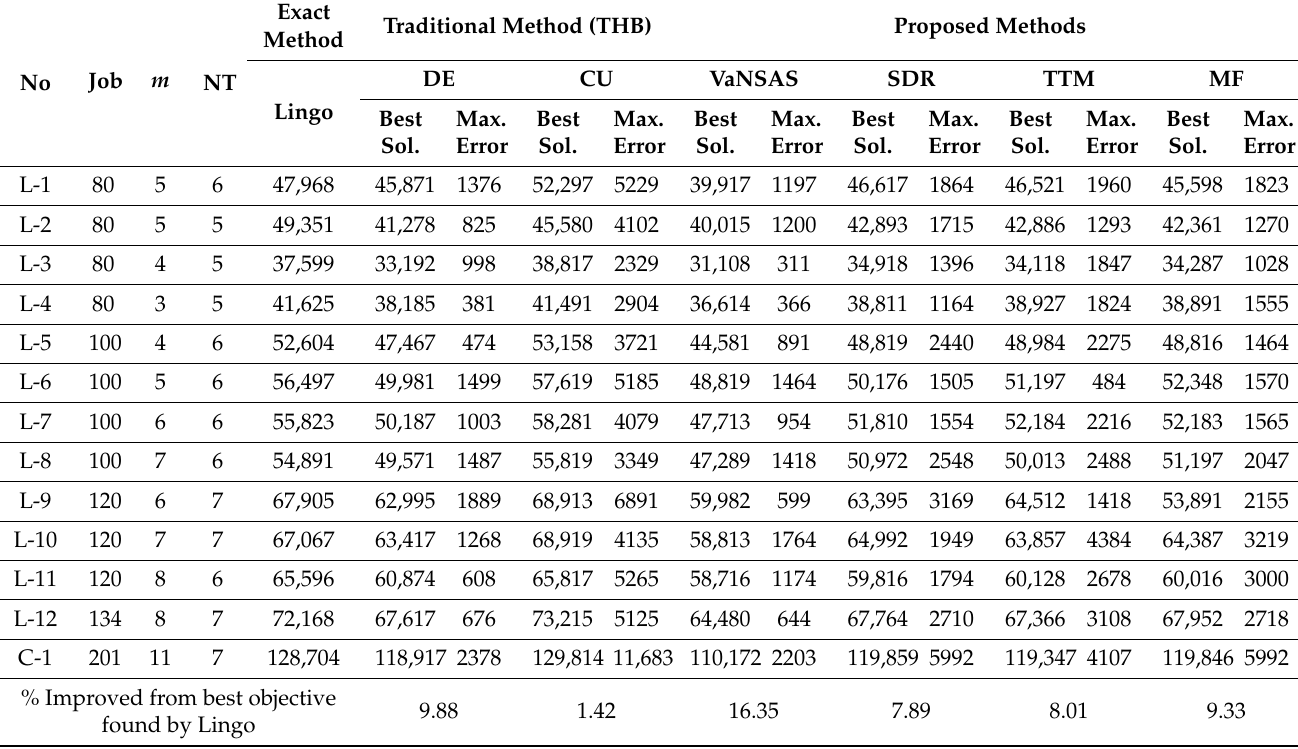
Table 13. Computation results of large test instances.